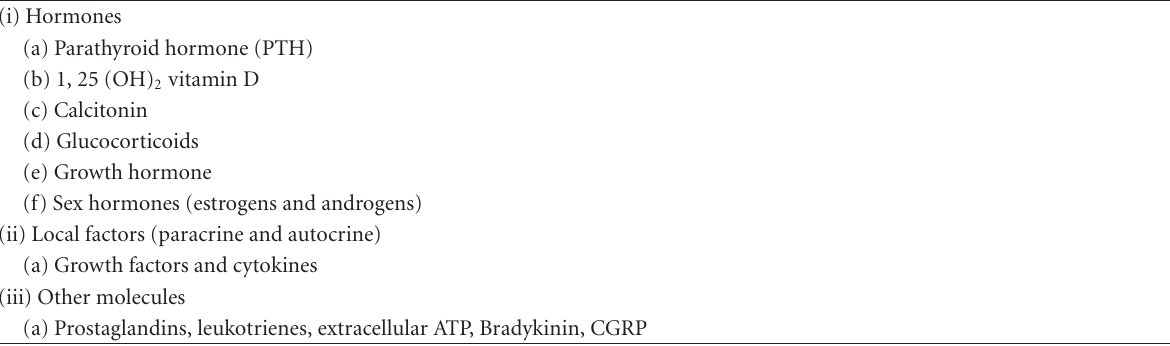
Table 2: Regulatory factors of bone